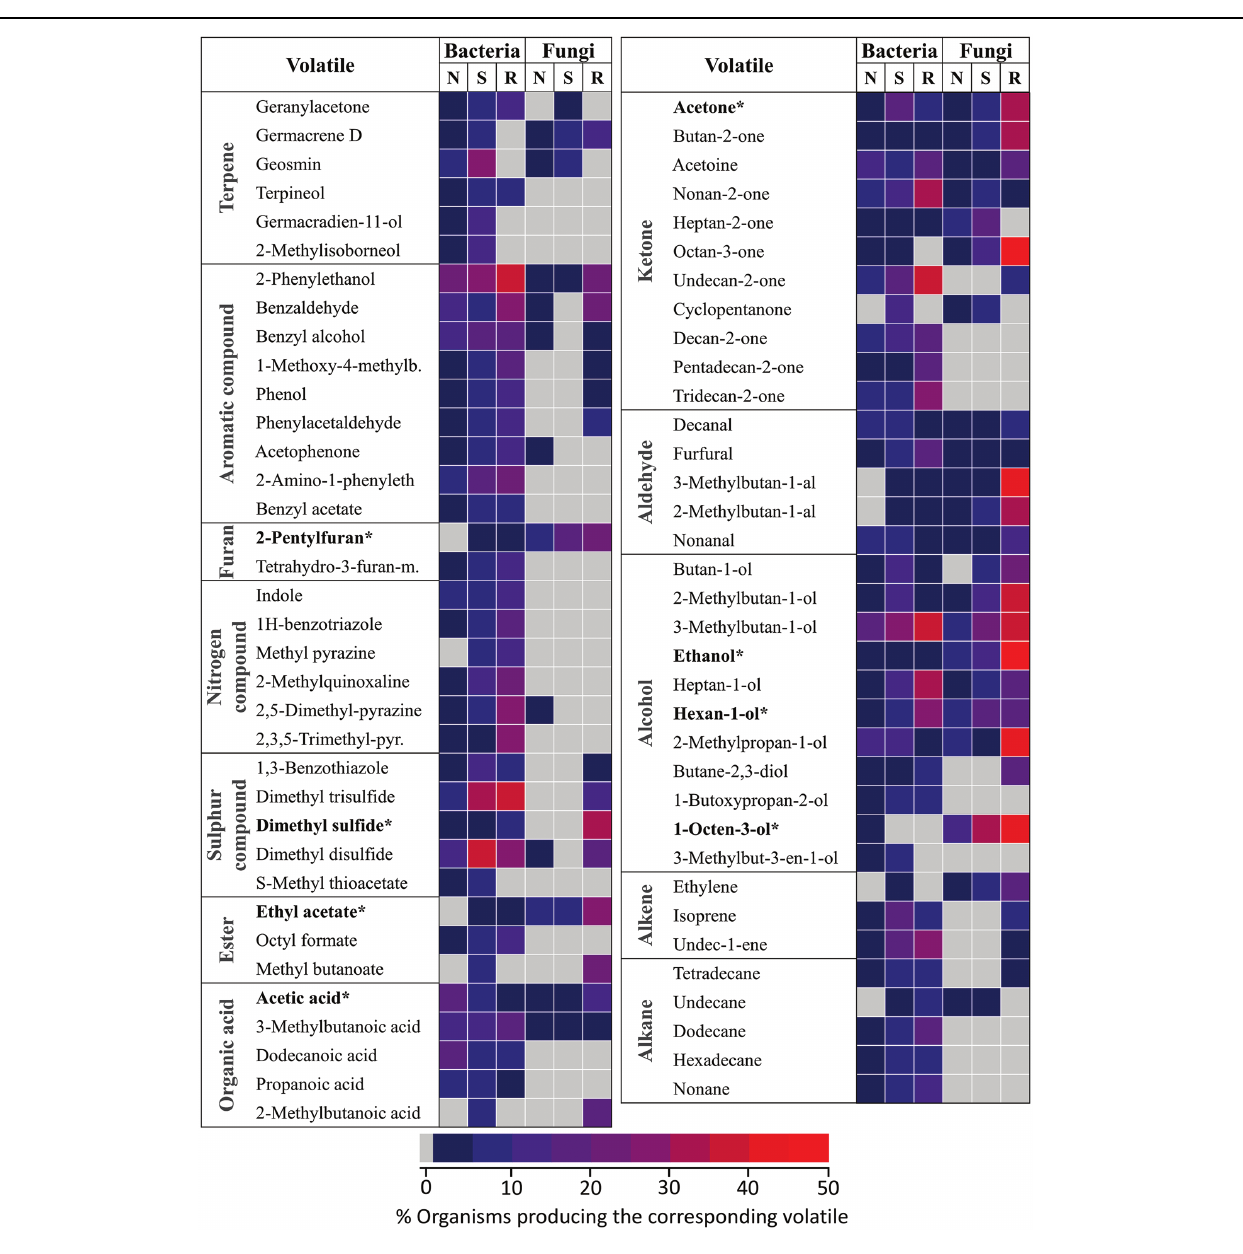
FIGURE 5 | Niche specificity of bacterial and fungal volatiles. Volatiles emitted by at least 10 different organisms from the mVOC database are shown. Microbes were classified based on their lifestyle/habitat as “soil” (120 bacteria, 36 fungi), “rhizosphere” (rhizo: 43 bacteria, 26 fungi) and “other” (157 bacteria, 64 fungi). The color code shows the frequency of each volatile in each group. ∗ These volatiles are also emitted by plant